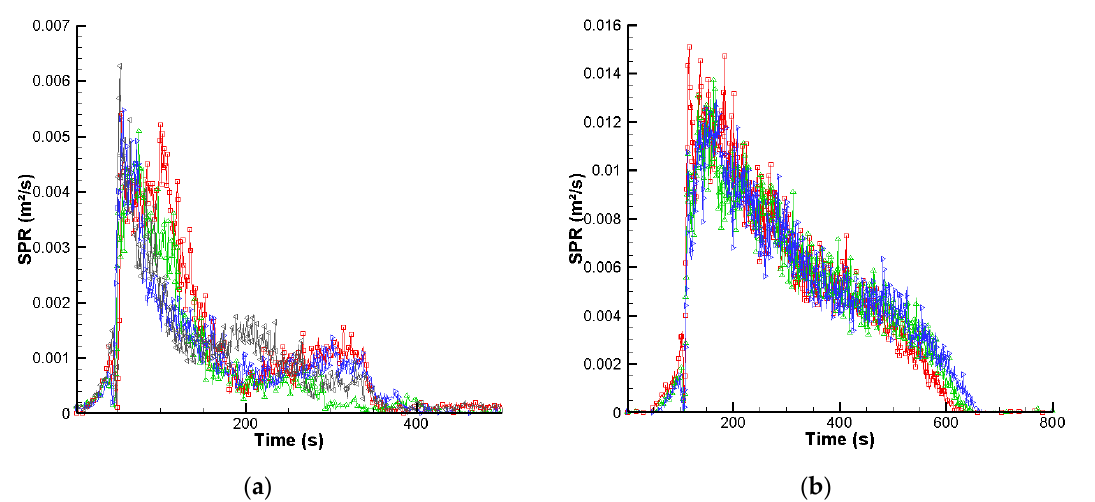
Figure 6. The Smoke Production Rate (SPR) as a function of time for wood samples submitted to a heat flux of 20 kW/m 2 for time to ignition of ( a ) t ign = 48 s and ( b ) t ign = 108 s (3 replicas).